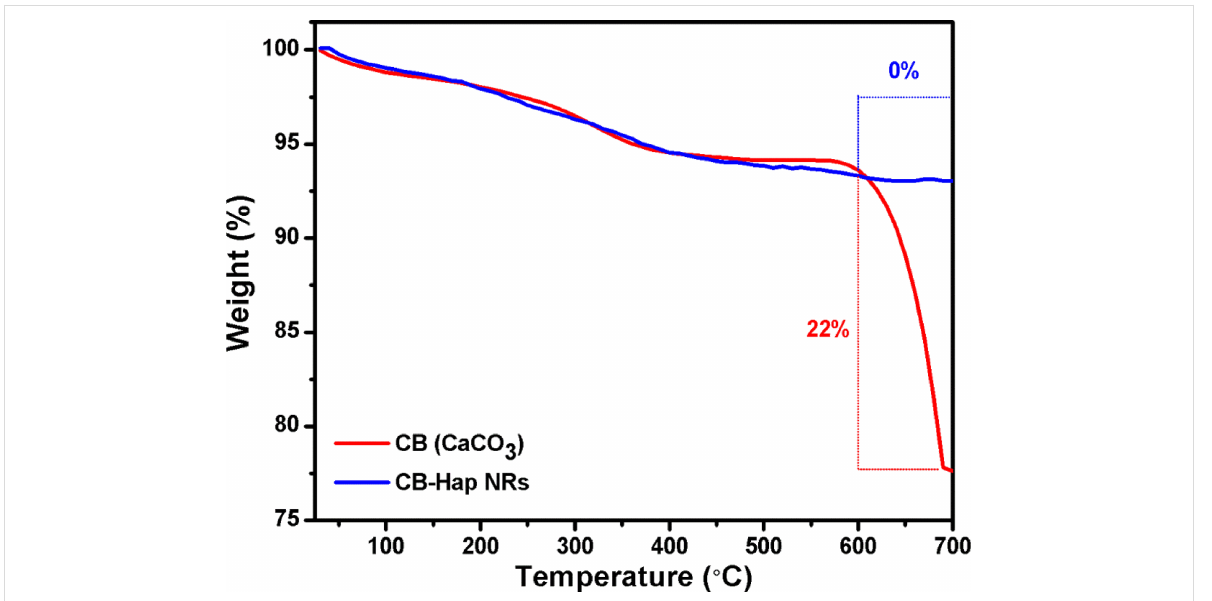
Figure 3: Thermogravimetric analysis (TGA) of cuttlefish bone (CB) powder and hydroxyapatite (Hap) nanorods using cuttlefish bone powder as a precursor (CB-Hap NRs).